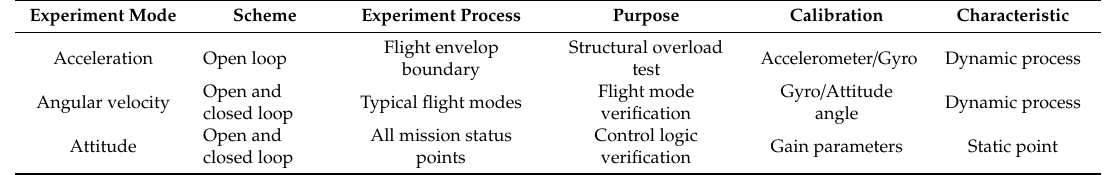
Table 9. Summary of the characteristics of three different experiment modes.